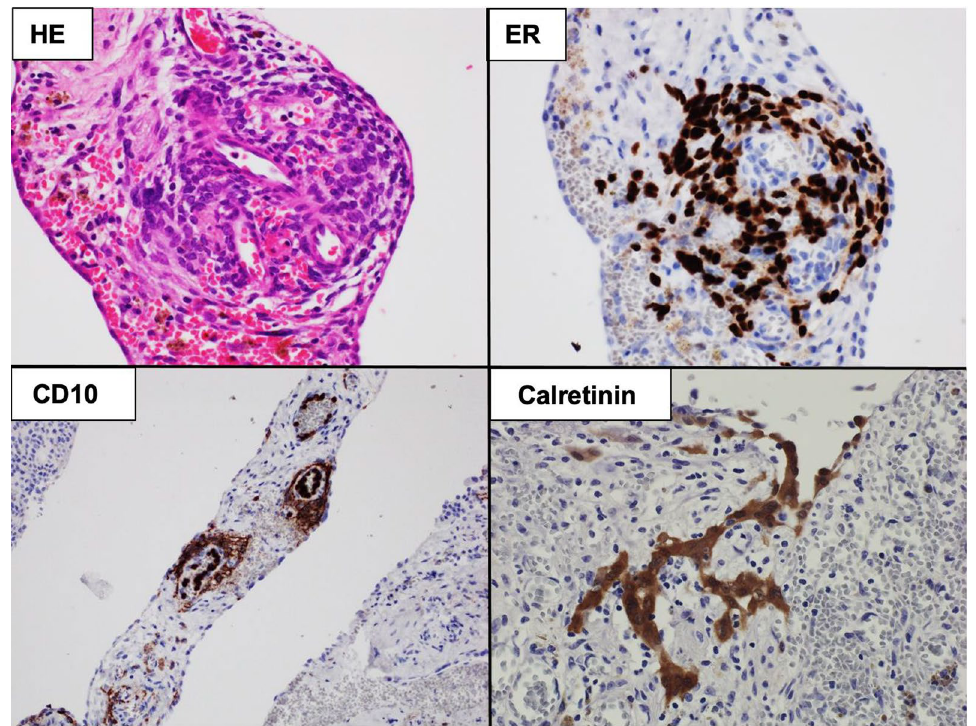
Fig. 4 Collection of spindle‑shaped cells in the subserosa on hematoxylin–eosin (HE) staining and positive estrogen receptor (ER) and CD10 immunostaining. Furthermore, the resected specimen was also positive for Calretinin stain